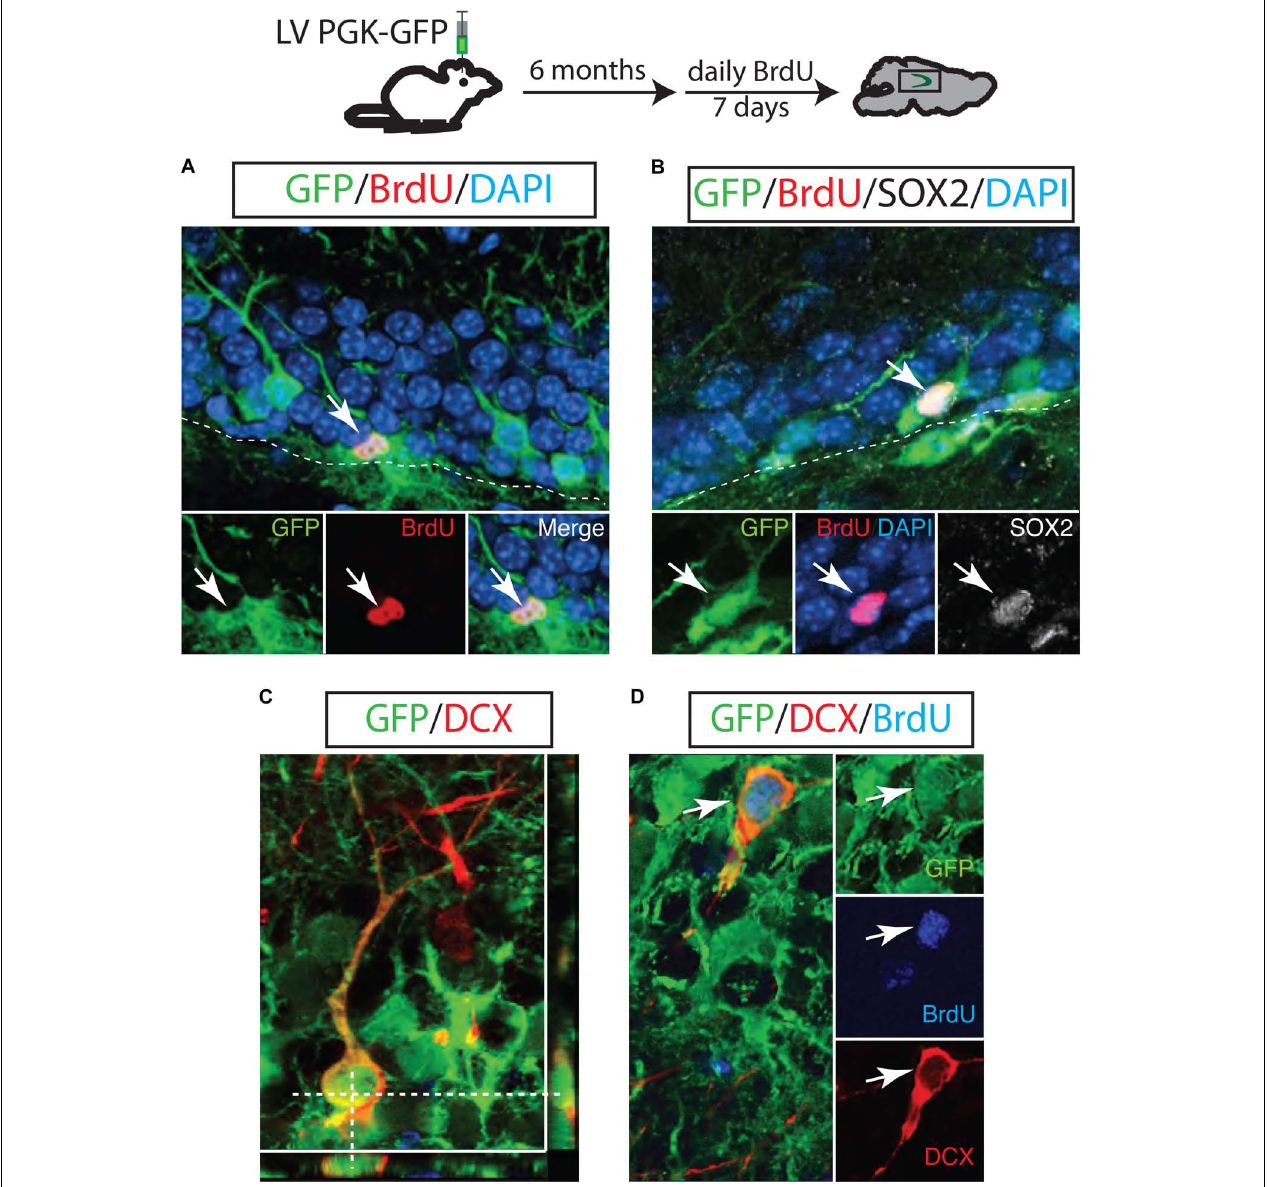
FIGURE 2 | A long-lasting NSC population in the adult hippocampus. GFP-positive neuroblasts were observed in the SGZ 6 months after LV PGK-GFP injection. Some GFP + cells incorporated BrdU (A) and maintained the expression of SOX2 (B) , indicating that LV PGK-GFP-labeled NSC populations retained the proliferation capacity over a six-month tracing period. Many of the GFP-labeled cells expressed the early neuronal marker doublecortin (DCX; C ). Higher magnification picture of the triple-labeled cells GFP/DCX/BrdU (D)